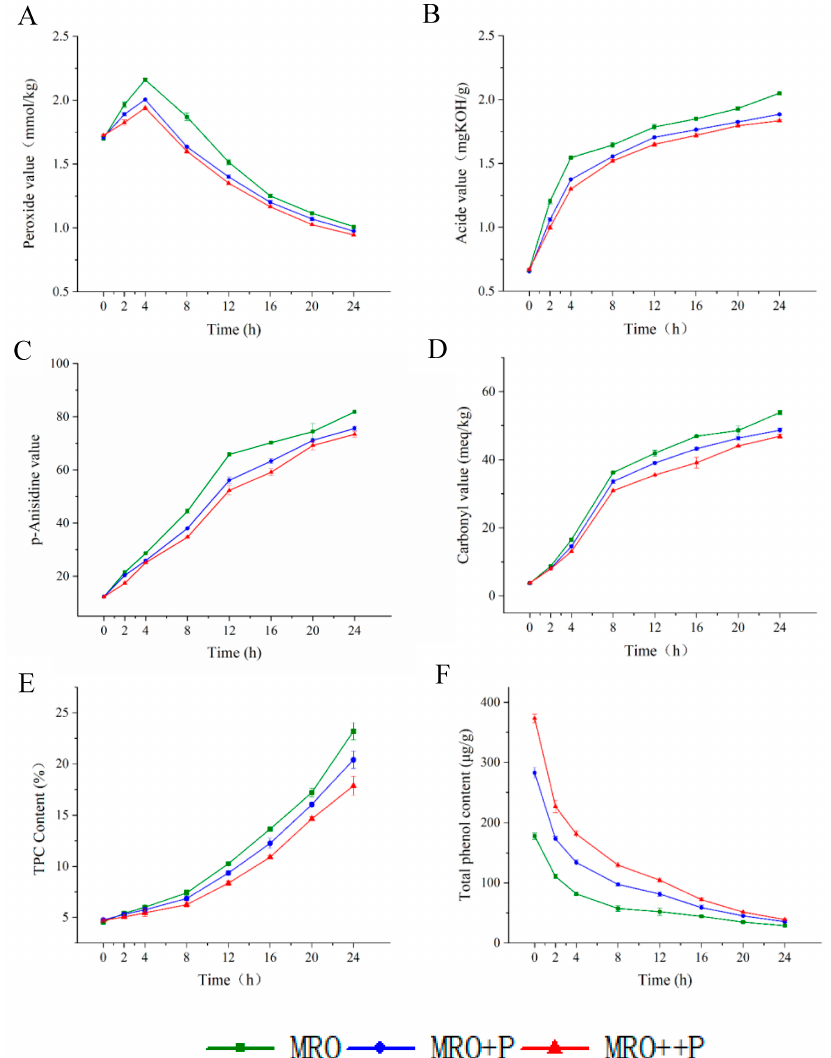
Figure 1. Changes of physicochemical properties of oil during frying process. ( A ) Peroxide value, ( B ) Acid value, ( C ) p-Anisidine value, ( D ) Carbonyl value, ( E ) Total polar compound content, ( F ) Total phenol content. Data are the mean of two independent experiments analyzed twice.